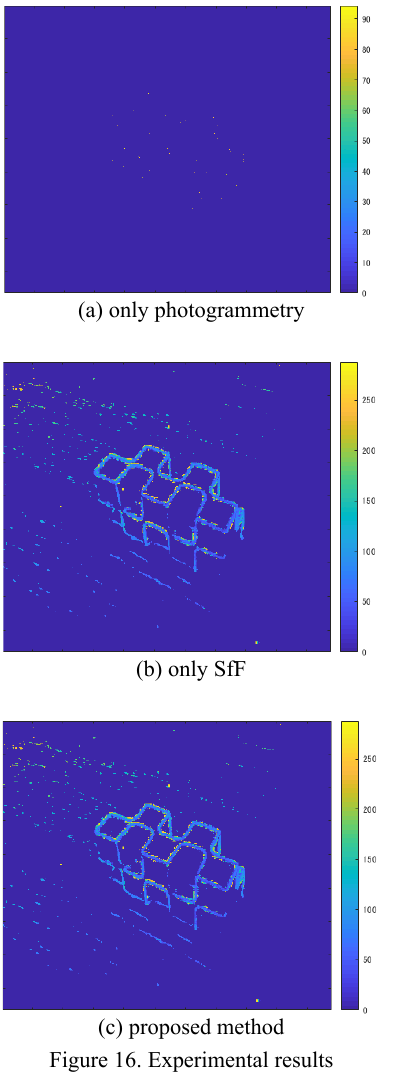
Figure 16. Experimental results